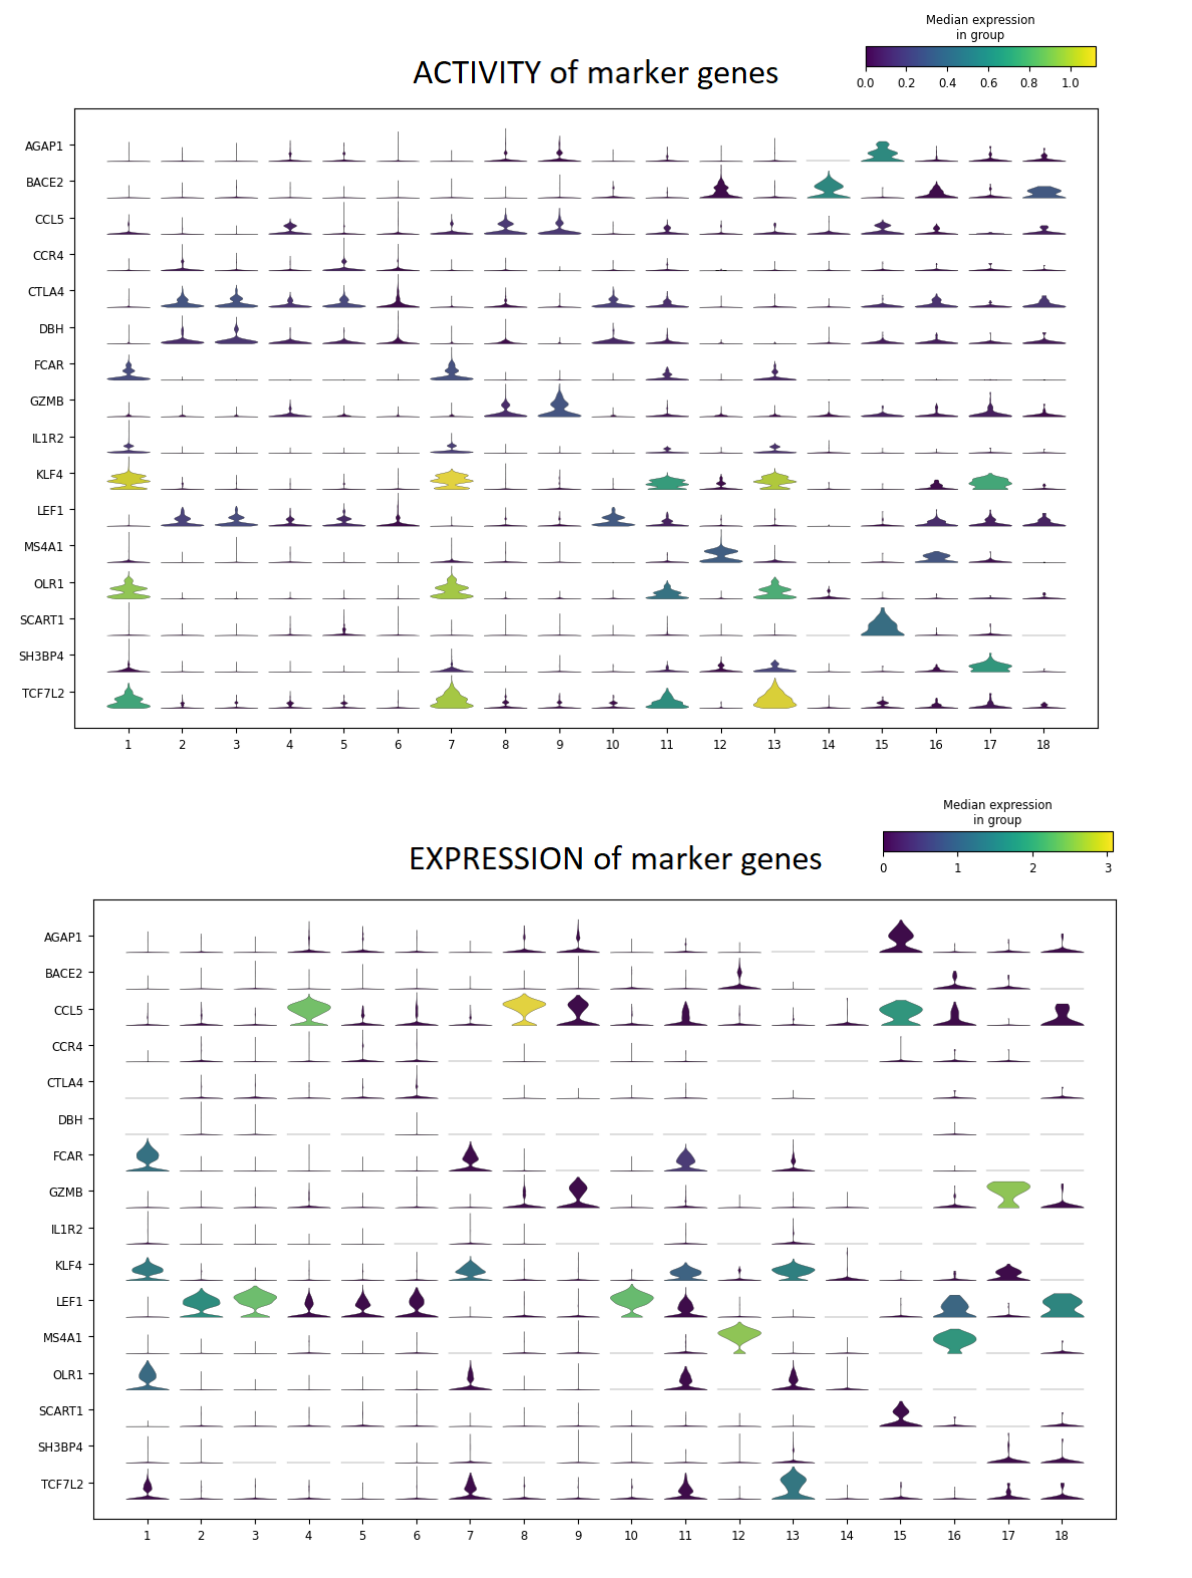
Figure 10. Violin Plots for the top DA genes for each cluster, of their Activity (on the top ) and Expression (on the bottom ), for the 10X Multiome Chromium X PBMC dataset. The two figures show a general coherence (especially for genes like MS4A1, AGAP1, and KLF4) between the activity and expression profiles on the same cells, showing consistency between the two biological